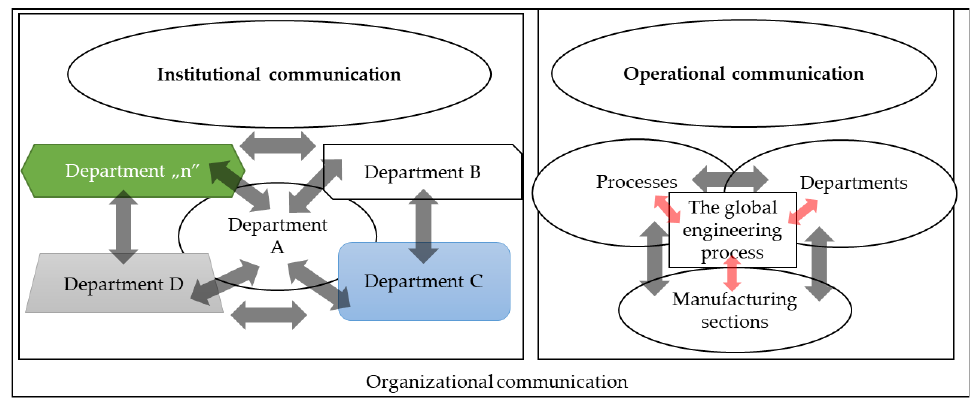
Figure 8. Locating the type of communication within the global engineering process related to or- ganizational communication.